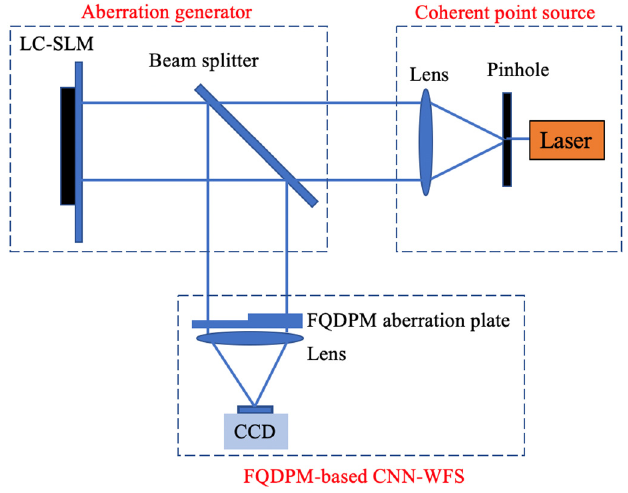
Figure 6. Schematic diagram of the optical system structure.